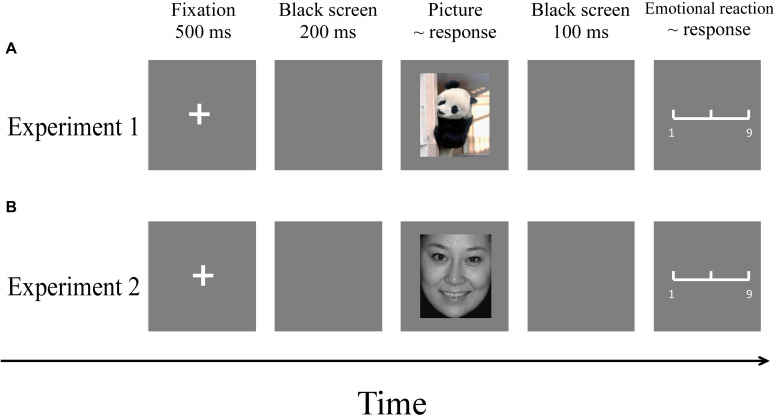
Flowchart describing the experimental designs. (A) Procedure of Experiment 1. (B) Procedure of Experiment 2. Note: Pictures were selected from the CAPS and the CFAPS that have been previously validated and used in published studies (Bai et al., 2005; Gong et al., 2011; Ma and Zhu, 2014; Wang et al., 2017).